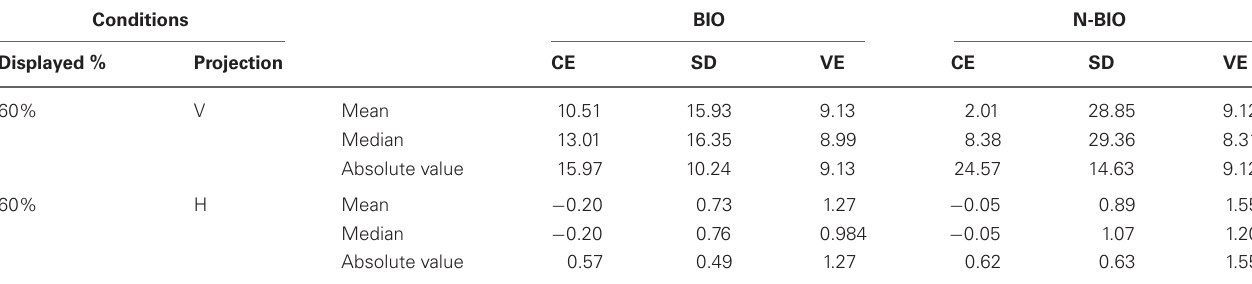
Table 1 | Results of Experiment